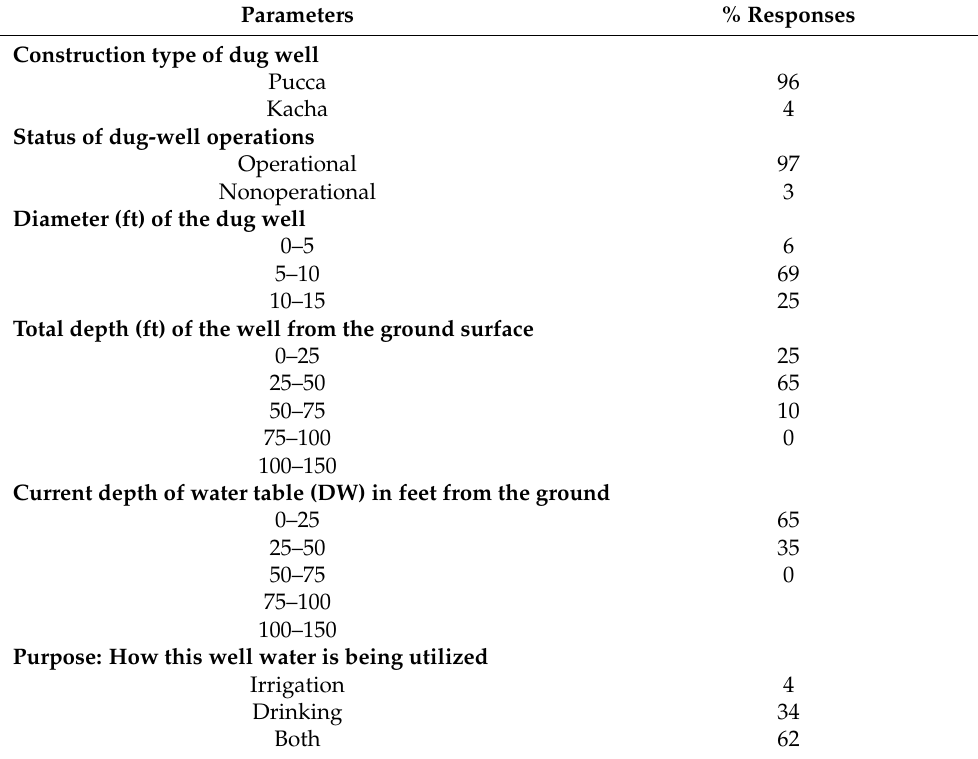
Table 4. Dug well Types and